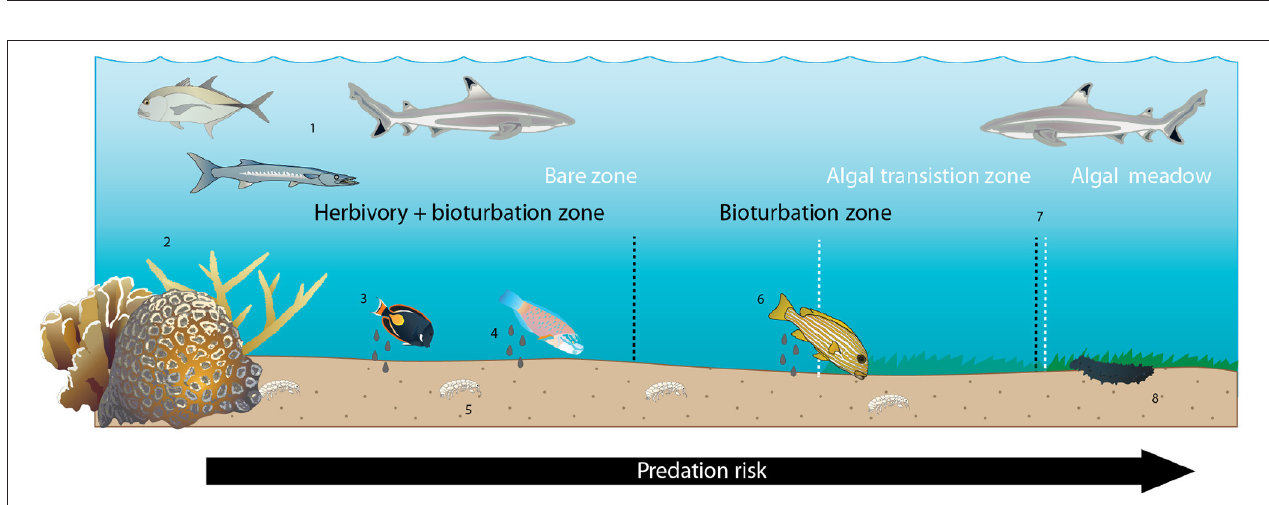
FIGURE 5 | Conceptual diagram of proposed and hypothesized drivers of halos at Heron Island. Zones indicated by white text and dashed lines are benthic algal zones; zones indicated by black text and dashed lines are ecological process zones. Numbers below refer to numbered icons that reflect patterns and processes known, observed in this study, or assumed to occur. (1) Predators generate predation risk through the lagoon seascape. (2) Coral patch reefs provide shelter from predators for smaller-bodied potential prey, creating a gradient of predation risk that increases with distance from patch reef shelter. (3) Herbivorous prey species graze benthic algae in a distance-sensitive manner, preferentially foraging in the immediate vicinity of the patch reef. (4) Foraging fishes defecate where they forage, creating elevated detrital input in the vicinity of the patch reef. (5) Some small benthic and infaunal invertebrates preferentially inhabit areas of higher fish activity, presumably due to elevated detrital resources, though others do not. (6) Larger-bodied bioturbating fishes preferentially forage in the vicinity of the reef, presumably due to elevated infaunal prey surrounding the reef and/or increased predation risk farther from the reef. (7) Declining net herbivory + bioturbation at increasing distances from the reef leads to increasing coverage of benthic algae over this gradient. (8) Larger-bodied scavenging invertebrates (sea cucumbers) preferentially forage near the reef and in the algal meadow beyond the halo boundary, presumably due to elevated faecal- and algal-derived detrital food availability, respectively.